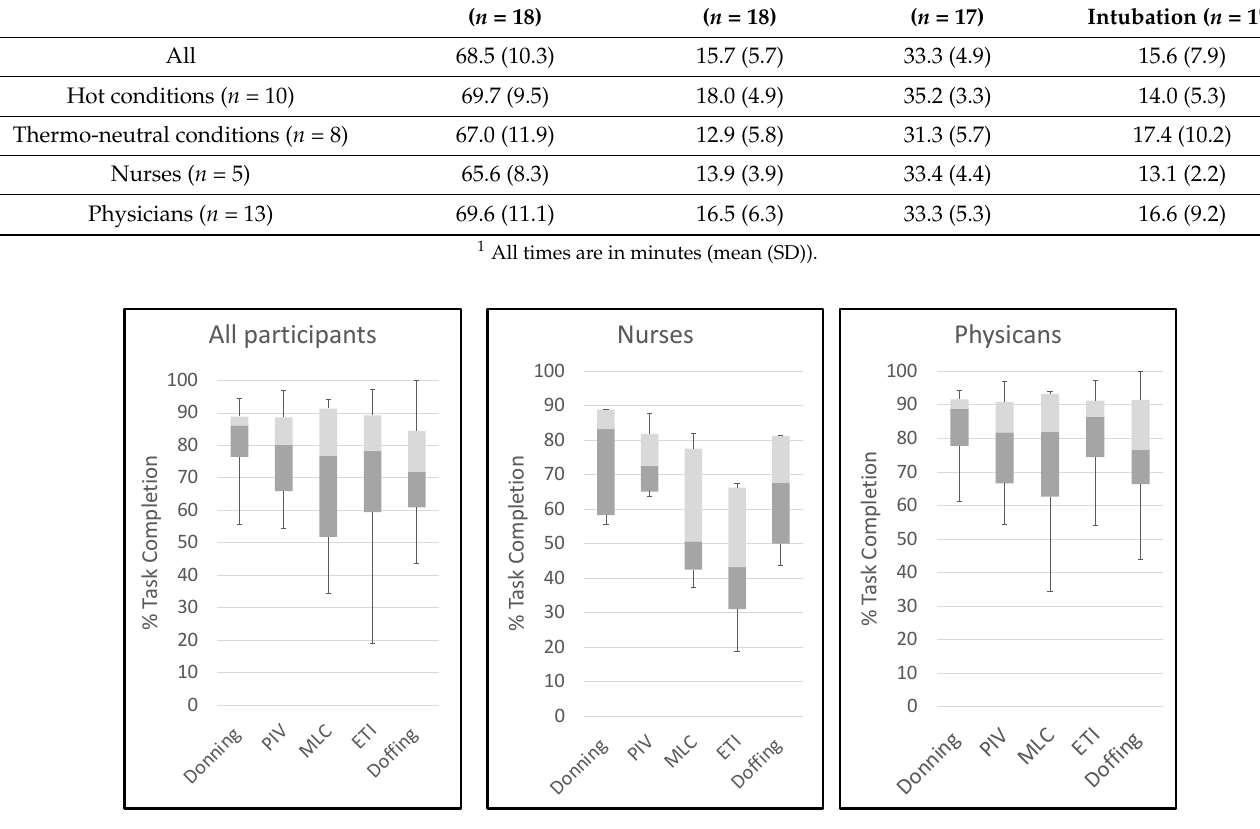
Figure 3. Boxplots showing median percentage (1st and 3rd quartiles) of completed tasks for each procedure for all participants ( n = 18, left panel), nurses ( n = 5, middle panel), and physicians ( n = 13, right panel). ETI and doffing had n = 17 (overall) and n = 12 (physicians). PIV, peripheral IV; MLC, midline catheter; ETI, endotracheal intubation.